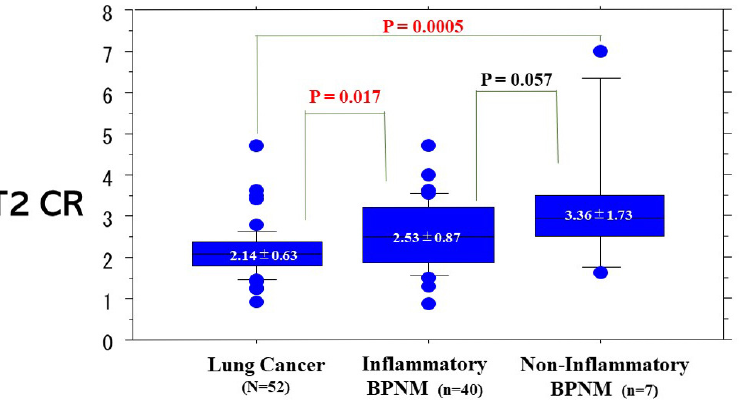
Figure 4. T2 Contrast ratio (CR) among lung cancers, inflammatory BPNMs and non-inflammatory MPNMs. T2 CR (2.14 ± 0.63) of lung cancers was significantly lower than that (2.53 ± 0.87) of inflammatory BPNMs ( p = 0.011) and significantly lower than that (3.36 ± 1.73) of non-inflammatory BPNMs ( p = 0.0005). T2 WIs are presented based on each diagnosis of PNMs (Figure 5). The T2 CR of lung cancers was significantly lower than that (2.93 ± 1.26) of pulmonary abscesses ( p = 0.0069), and not significantly lower than that (2.49 ± 0.80) of mycobacteria infections ( p = 0.11).